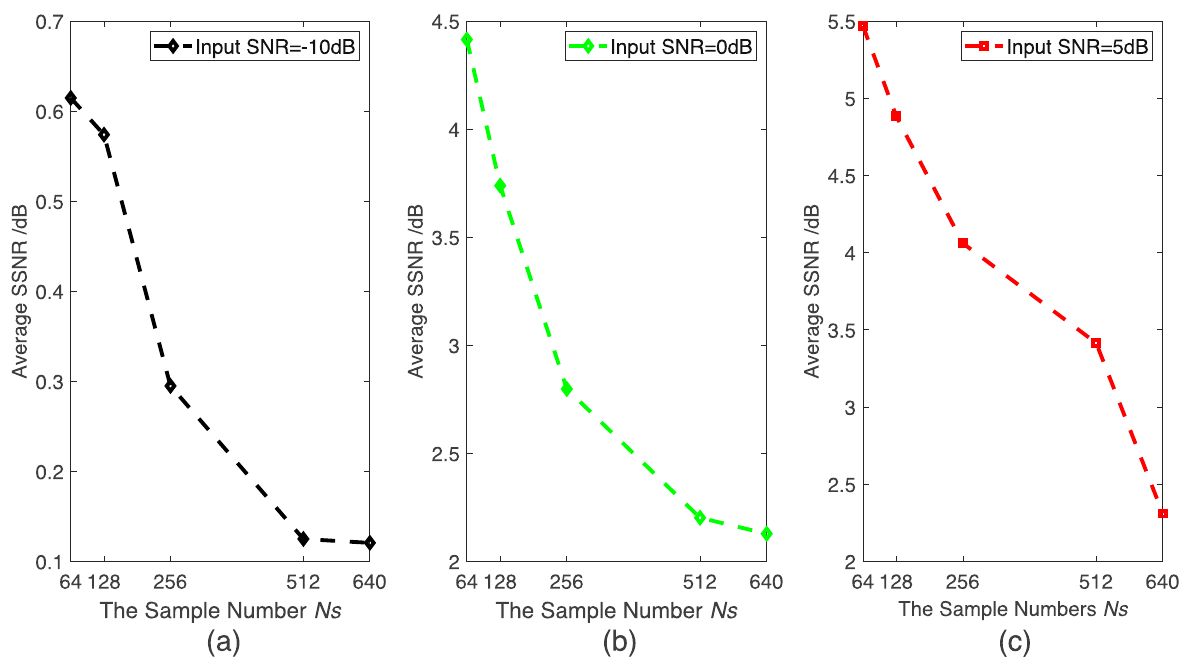
Fig. 4 The output SNR versus the sample number N s of the proposed GMMSE-KGL method